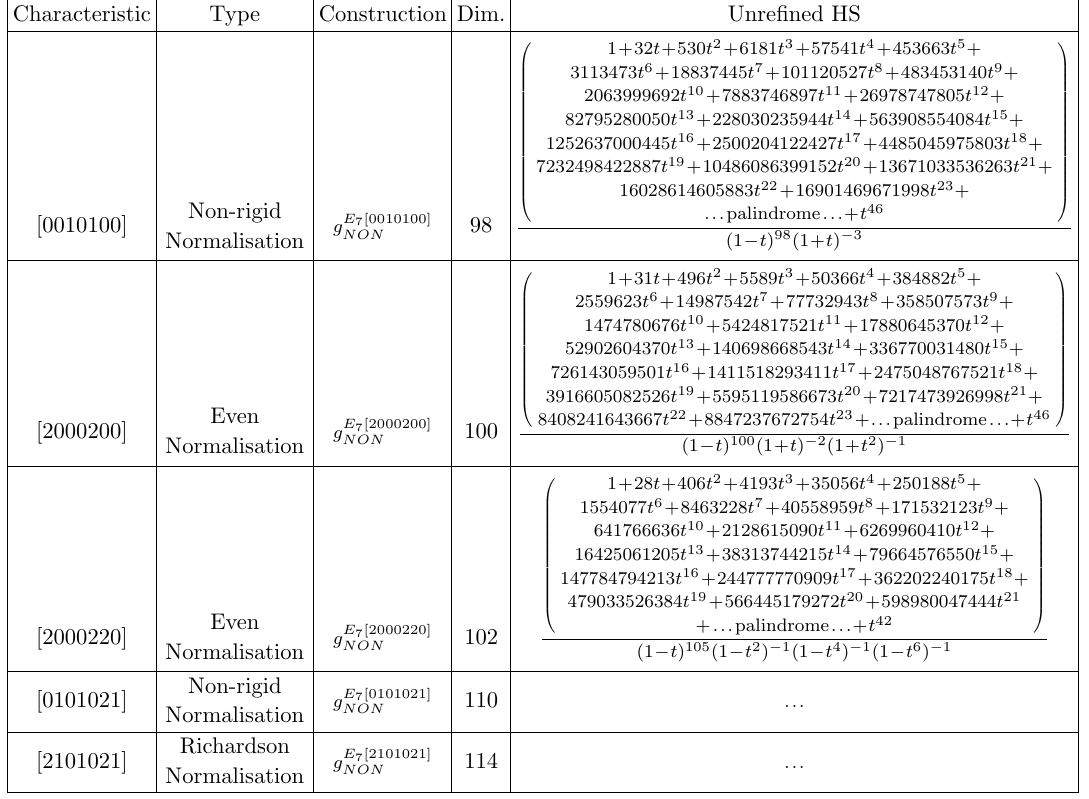
Table 25 . E 7 nilpotent orbit normalisations and Hilbert series (B). Some orbits in the upper Hasse diagram remain to be